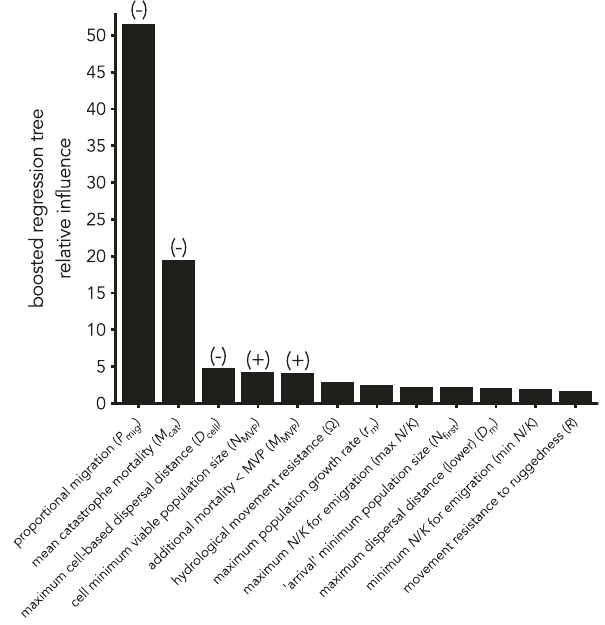
Fig. 5 Global sensitivity analysis results. Shown are relative inference scores (summing to 100 across all parameters considered) from a boosted- regression tree 93 of the relative importance of the model parameter ranges on the time taken to reach continental saturation. See main text for parameter descriptions and ranges tested. The most in fl uential parameters ( fi ve top-ranked) are also given with the direction of their in fl uence on the timing of continental saturation: ( − ) = negative, ( + ) = positive. Settings for the boosting regression tree were: error distribution = Gaussian, bag fraction = 0.75, learning rate = 0.008, tolerance = 0.0001, maximum number of trees = 10,000, and tree complexity = 2. See also Supplementary Fig.